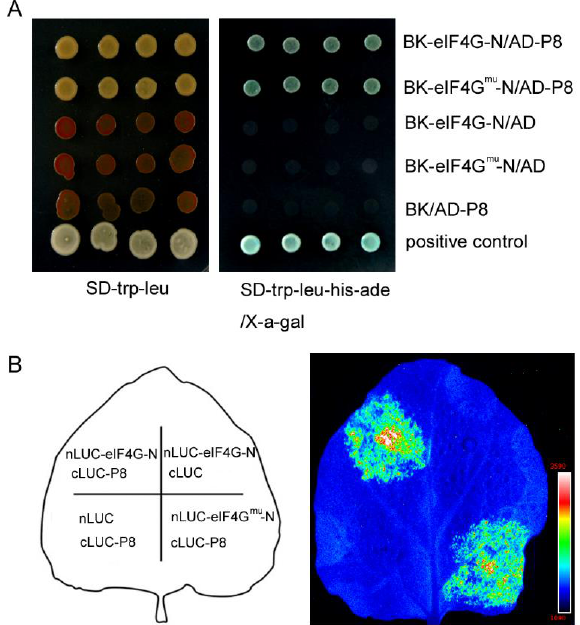
Figure 5. N-terminus of eIF4G (eIF4G-N) interacts with RBSDV P8 in yeast and in planta. ( A ) Yeast two-hybrid assays show that eIF4G-N interacts with the RBSDV P8 protein. The plasmid combinations indicated on the right side of the image panel were cotransformed into yeast strain Y2H Gold, and the yeast cells were spotted on SD/-Trp/-Leu and SD/-Trp/-Leu/-His/-Ade selective medium with X-a-gal and grown at 30 °C for 3 – 4 d. Positive control, full-length pGADT7 – 53 and pGBKT7-T7. ( B ) The luciferase complementation imaging assay indicates that eIF4G-N interacts with the RBSDV P8 protein in planta. The plasmid combinations indicated on the left side of the image panel were coexpression Nicotiana benthamiana leaves by Agrobacterium-mediated infiltration. After 48 h, N. benthamiana leaves were sprayed with Lucifer, and a fluorescence signal appeared where eIF4G-N-nLuc or eIF4G mu -N-nLuc was coexpressed with cLuc-P8. eIF4G mu , eIF4G mutant protein generated by CRISPR/Cas9.